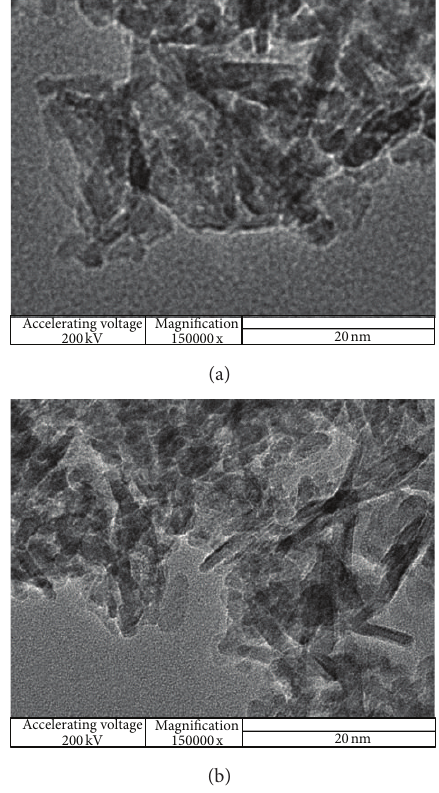
Figure 4: (a) TEM images of nano- 𝛾 -Al 2 O 3 . (b) TEM images of sulfonic acid functionalized nano- 𝛾 -Al 2 O 3 .